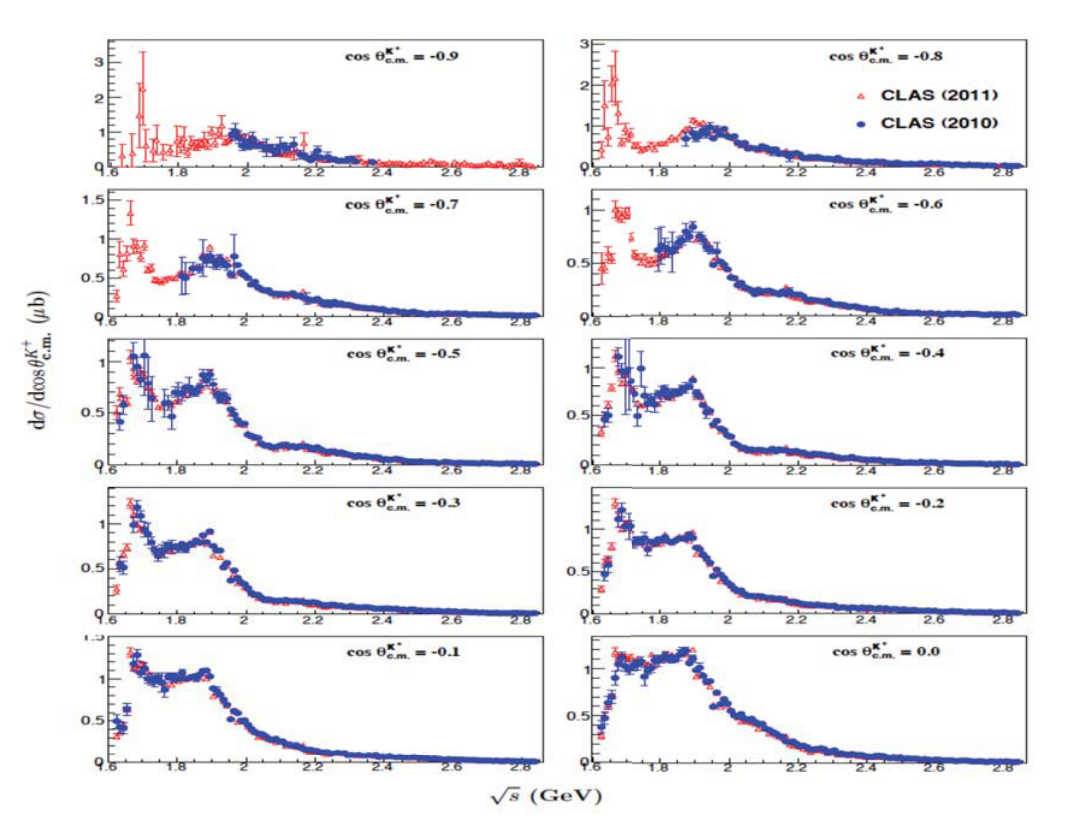
Fig. 2 Invariant mass dependence of the γp → K + Λ differential cross section in the backward polar angle range. There are 3 structures visible that may indicate resonance excitations, at 1.7, 1.9, and 2.2 GeV. The blue full circles are based on the topology K + pπ − , the red open triangles are based on topology K + p or K + π − , which extended coverage towards lower W at backward angles and allows better access to the resonant structure near